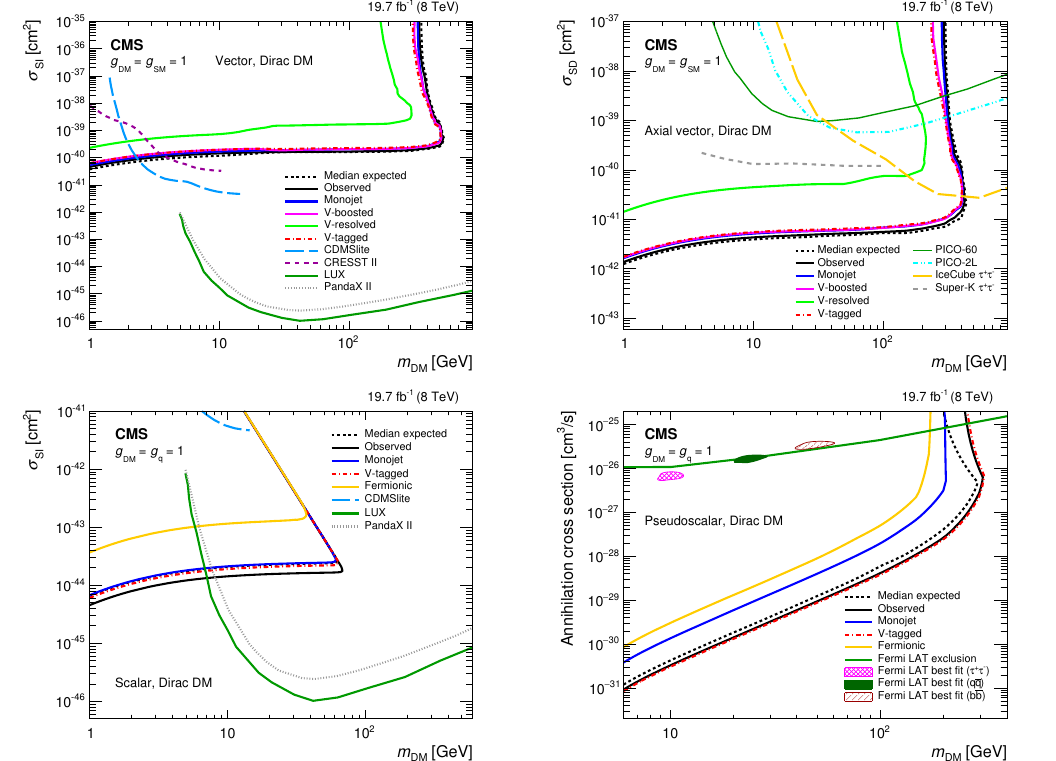
Figure 11 . The 90% CL exclusion contours in the m DM (cid:0) (cid:27) SI or m DM (cid:0) (cid:27) SD plane assuming vector (top-left), axial vector (top-right), scalar (bottom-left) mediators. Also shown is the 90% CL exclusion in DM annihilation cross section as a function of m DM for a pseudoscalar mediator (bottom-right). For the scalar and pseudoscalar mediators, the exclusion contours assuming the mediator only couples to fermions (fermionic) is also shown. The excluded region in all plots is to the top-left of the contours for the results from this analysis while the DD experiments and Fermi LAT excluded regions are above the lines shown. In the vector and axial vector models, limits are shown independently for monojet, V-boosted, and V-resolved categories. The red dot-dashed line shows the partial combination of the V-tagged categories for which the V-boosted category provides the dominant contribution. In all of the mediator models, a minimum mediator width is assumed. For the pseudoscalar mediator, 68% CL preferred regions, obtained using data from Fermi LAT, for DM annihilation to light-quarks (qq), (cid:28) + (cid:28) (cid:0) , and bb are given by the solid green, hatched pink, and shaded brown coloured regions,